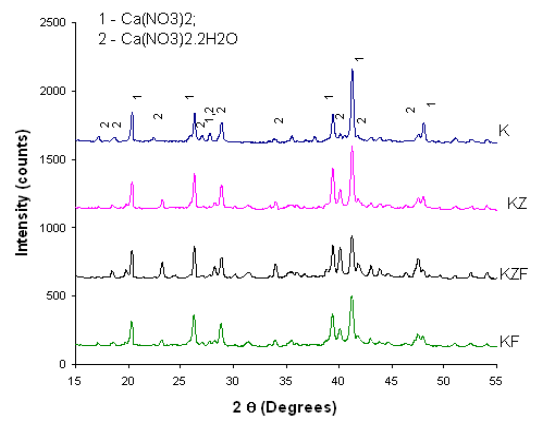
Figure 3. XRD spectra of dry gels (white